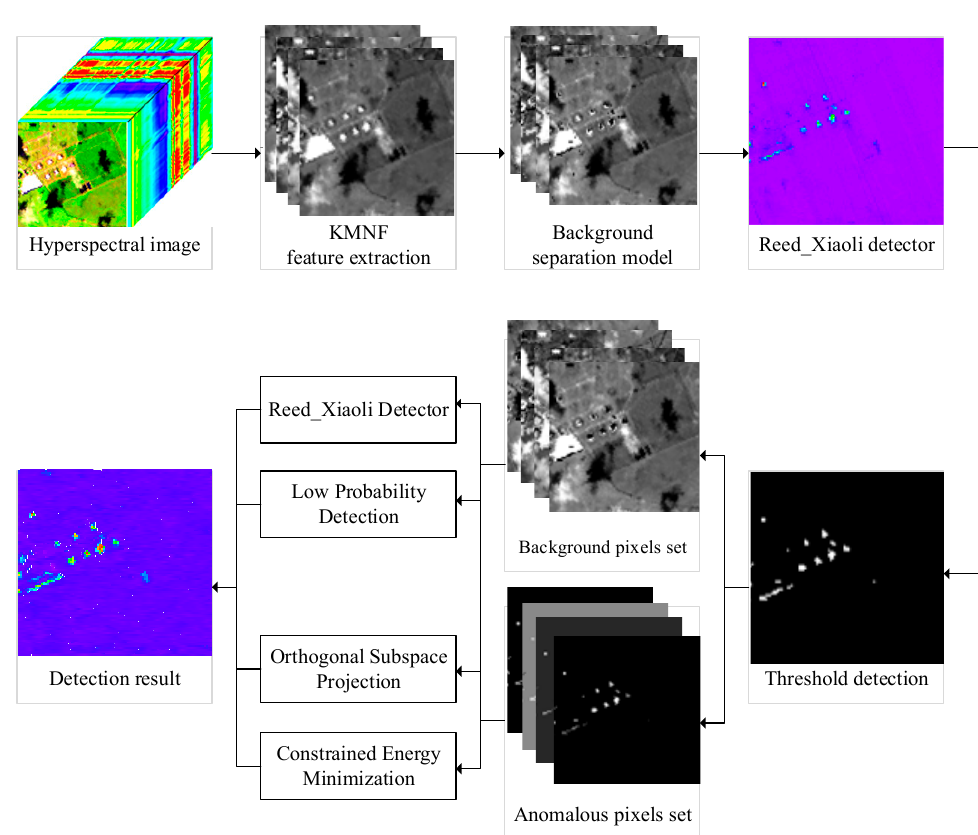
Figure 1. Framework of KMNF-BSM-based anomaly detection.